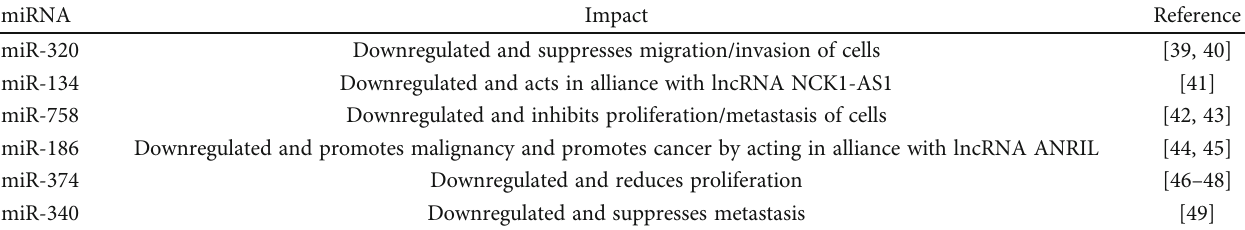
Table 3: PIK3CA miRNAs mined from the TargetScan database with a putative role in cervical cancer.